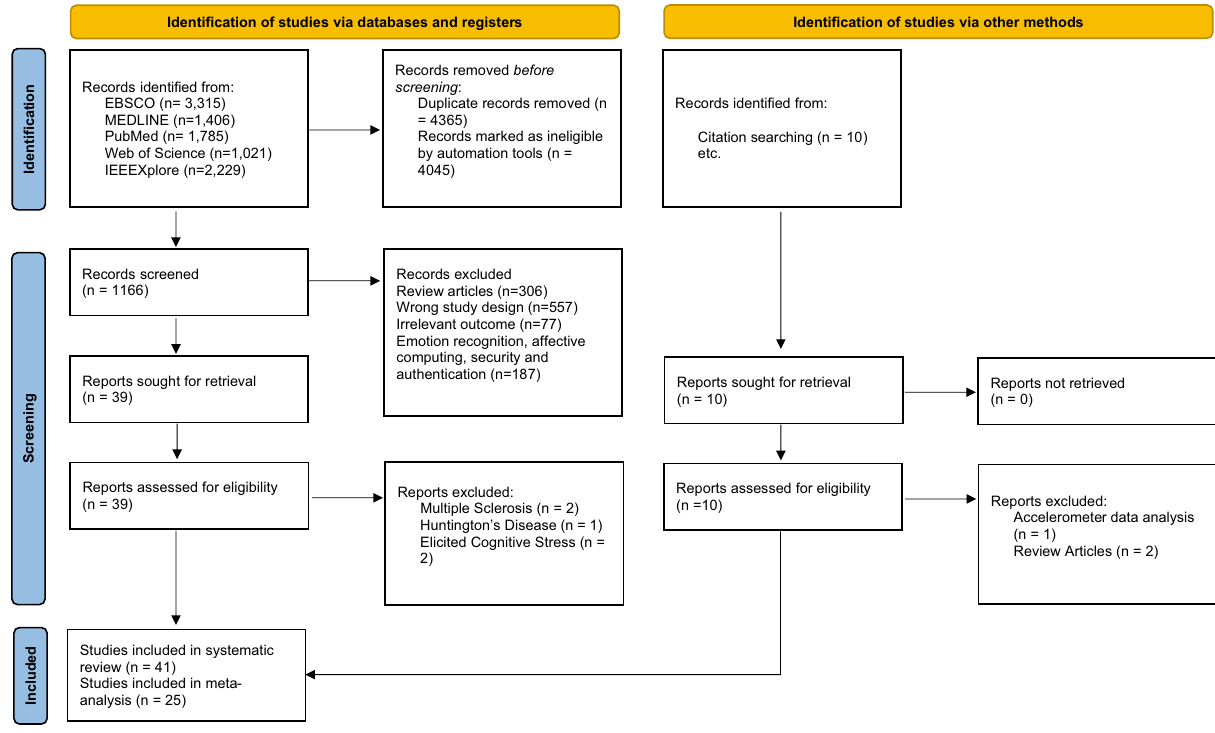
Figure 1. PRISMA 2020 flow diagram for study